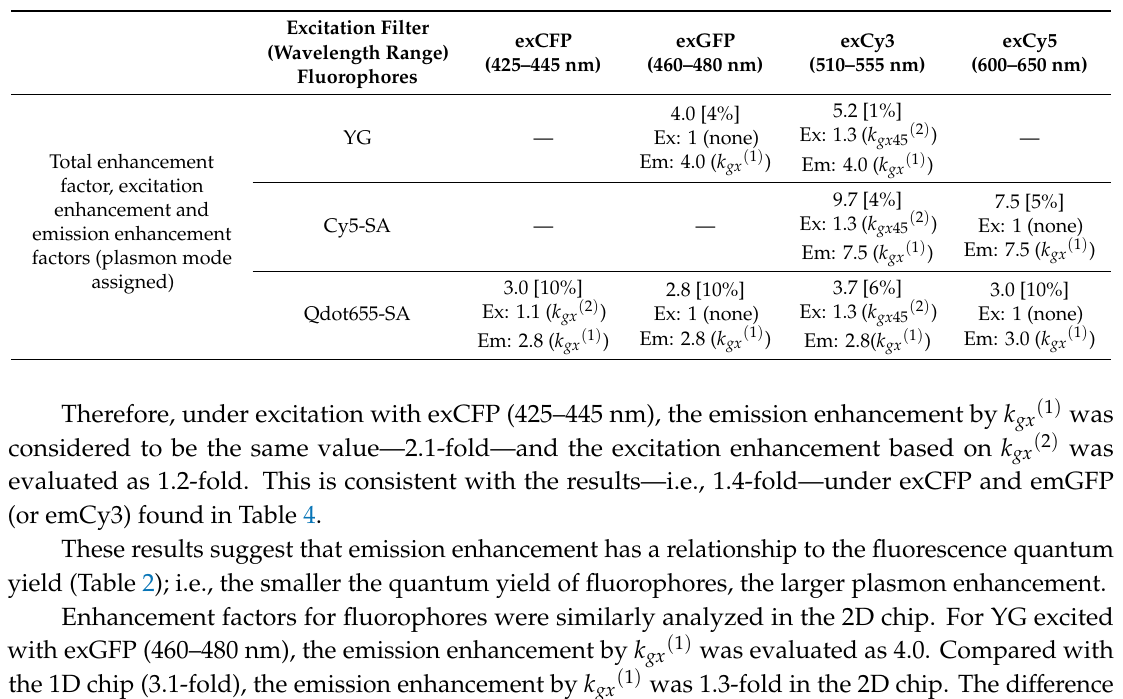
Table 9. Fluorescence enhancement factors of the fluorophores with emCy5 for the 2D chip in the epi-optical system. The values inside [%] correspond to